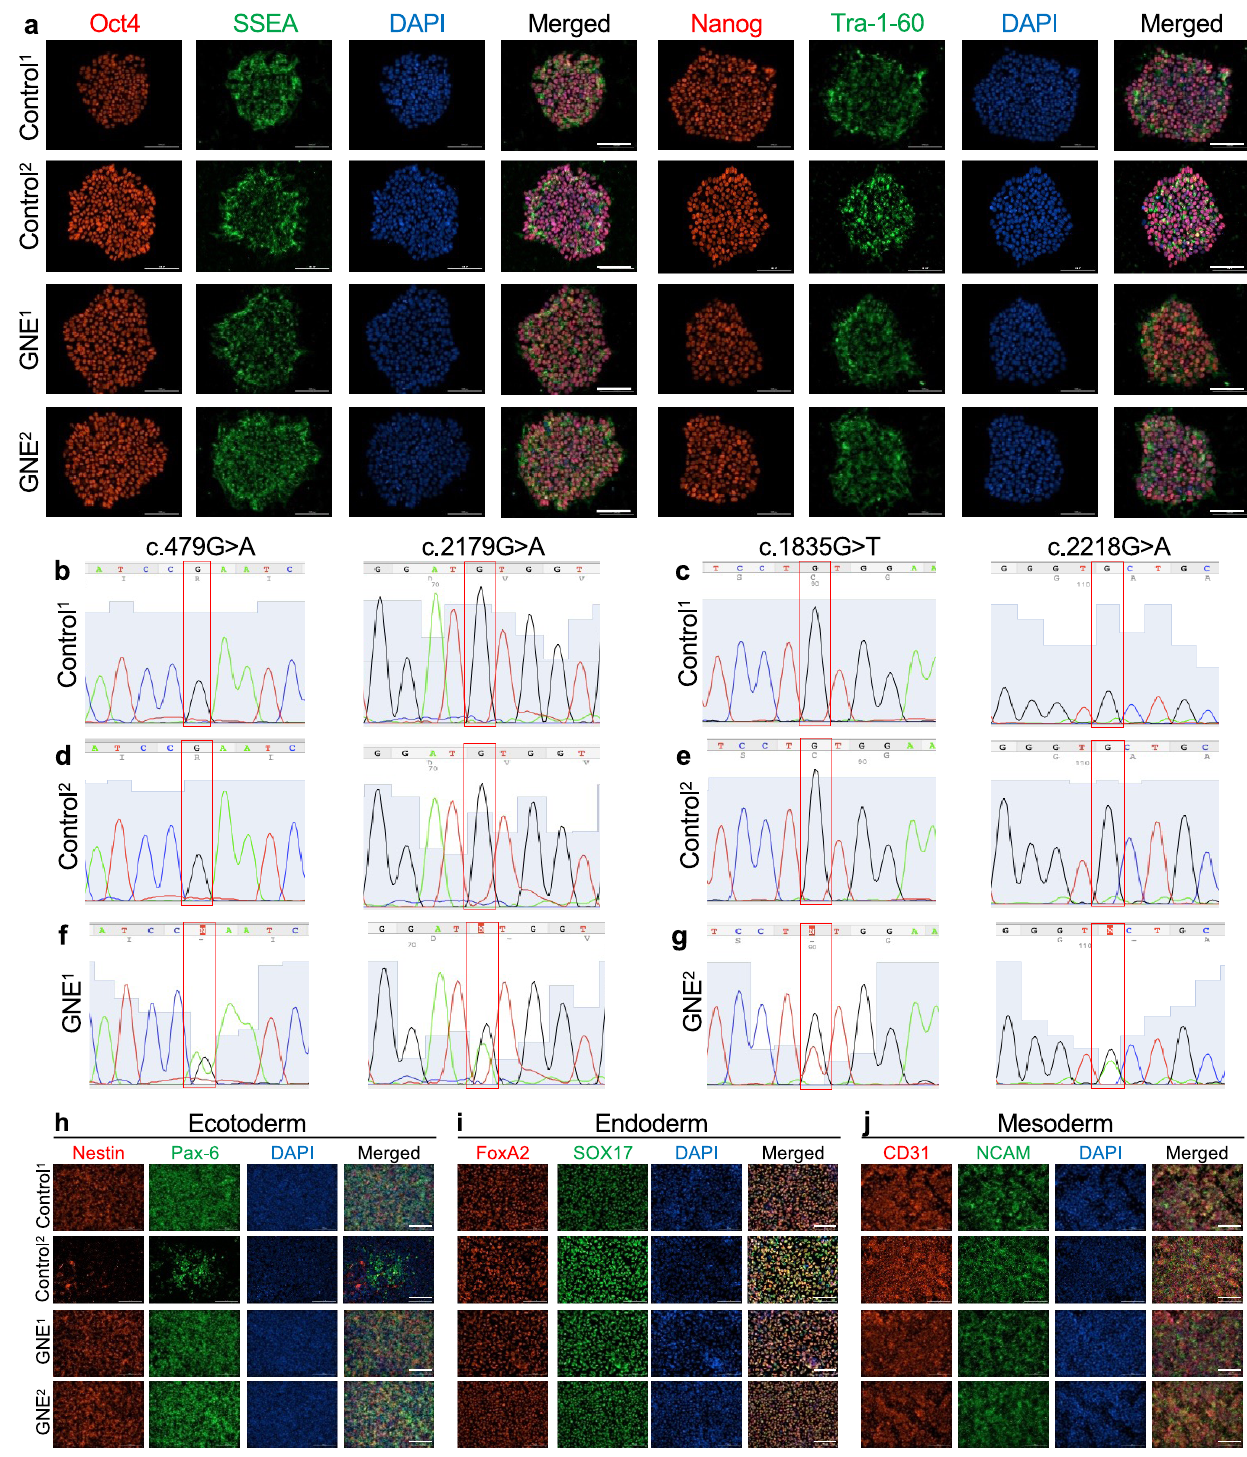
Fig. 2 iPSC con fi rmation of pluripotency marker expression, GNE mutation sequencing, and germ layer differentiation capabilities. a Control 1 (top row), Control 2 (second row), GNE 1 (third row), and GNE 2 (bottom row) iPSCs were assessed for expression of standard pluripotency markers by immuno fl uorescence (IF). All clones expressed Oct4, SSEA, Nanog, and Tra-1-60. b – g Sanger sequencing plots con fi rming the presence of the compound heterozygous patient mutations. Control samples contain the wild-type alleles at all mutant locations (red boxes, Control 1 : b , c , Control 2 : d , e ), whereas GNE 1 are heterozygous for wild-type and mutant alleles (red boxes, f ) as is GNE 2 (red boxes, g ). h – j IF images highlighting germline differentiation capacity. Differentiated iPSCs were capable of expressing standard ectoderm (Nestin and Pax-6) ( h ), endoderm (FoxA2 and SOX17) ( i ), and mesoderm (CD31 and NCAM) markers ( j ). All images are representative. a and h – j images are ×20, scale bars: 100 μ